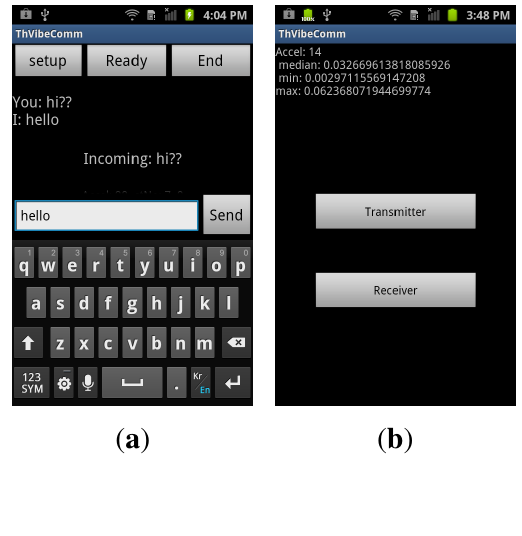
Figure 8. Screen shots of the VibeComm prototype. ( a ) Sending and receiving; ( b ) threshold adjustment.